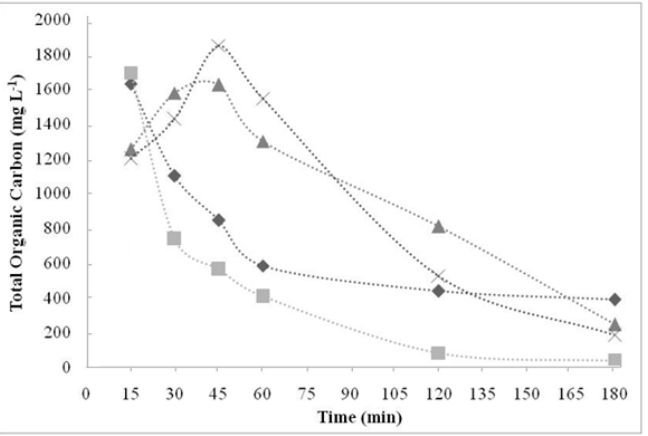
Figure 1. Total Organic Carbon as a function of time. Condition ([FeSO 4 ·7H 2 O] 0 , mmol L − 1 ): ( ) 25; ( ) 50; ( ) 100; ( ) 150.